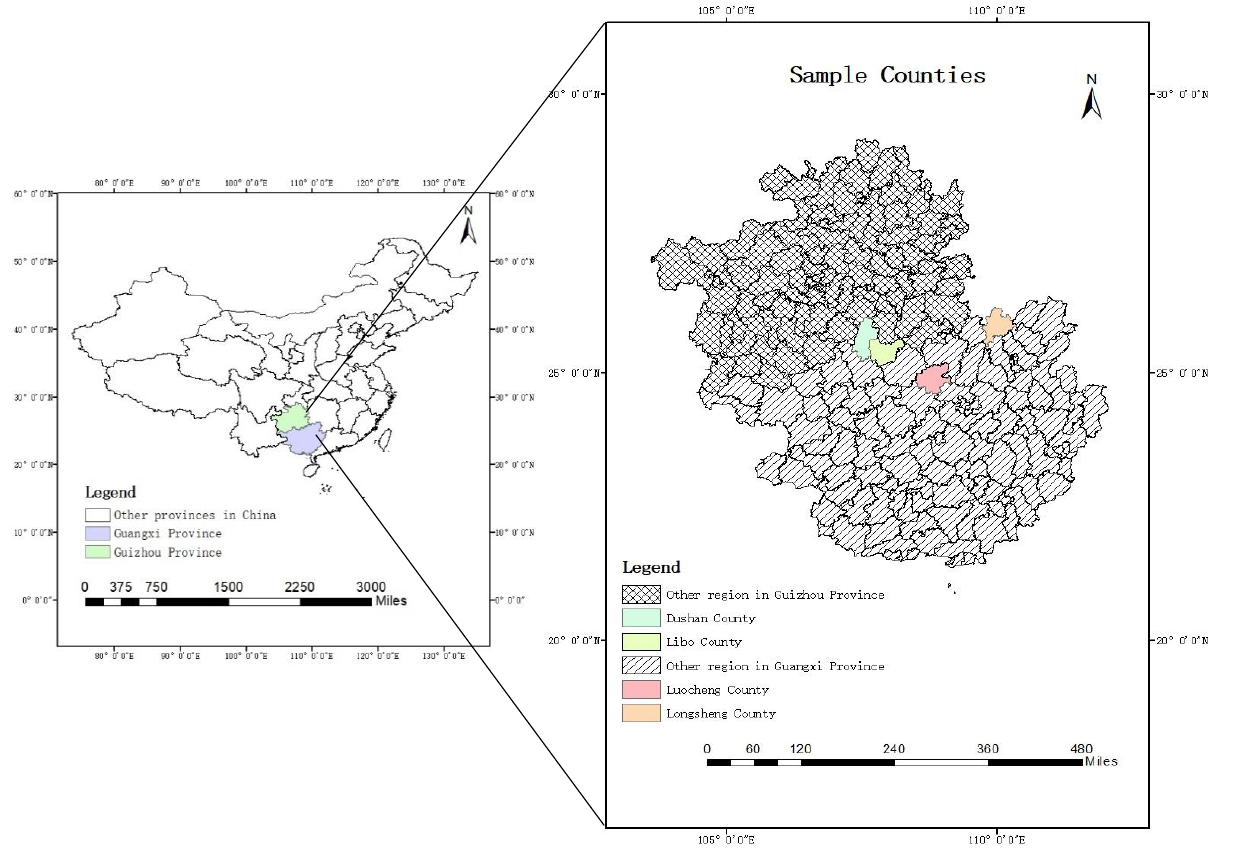
Figure 1. Location of sample counties.